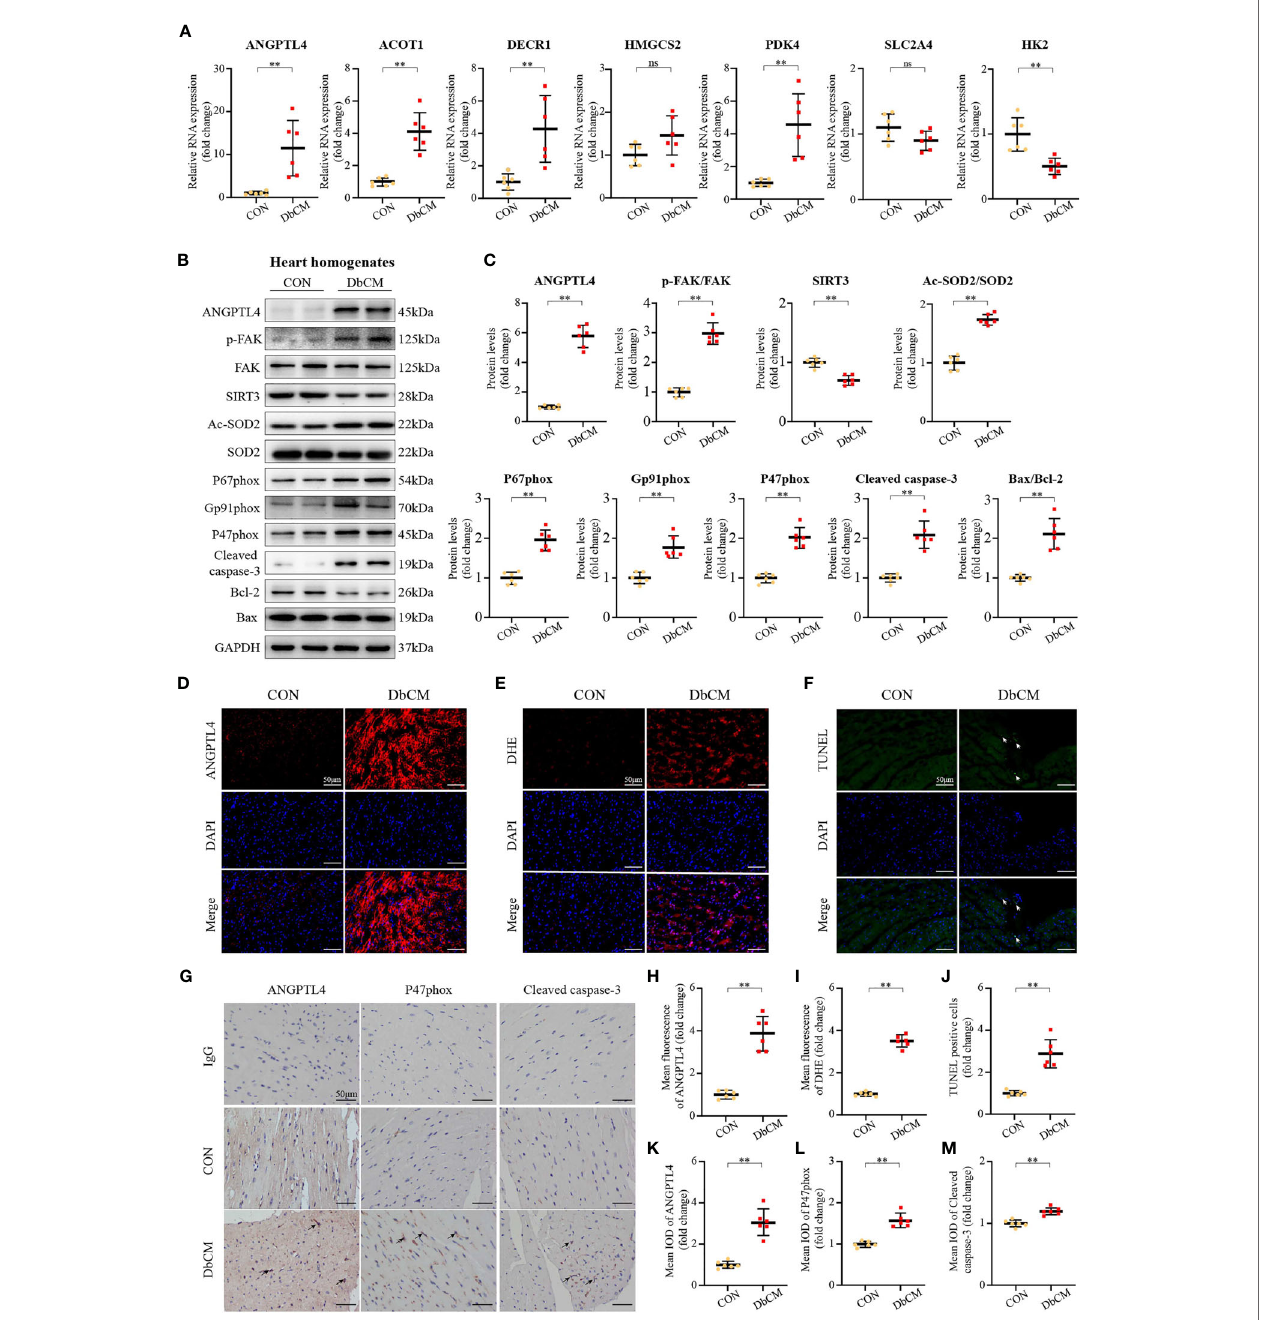
FIGURE 6 | Screening of a novel therapeutic target for DbCM. (A) Relative mRNA expression of hub genes normalized to a GAPDH internal control (n=6 each). Values are expressed relative to control groups. (B, C) Representative Western blots and analysis of ANGPTL4 expression; p-FAK(Y397)/FAK ratio; SIRT3 expression; Ac-SOD2/SOD2 ratio; P67phox expression; Gp91phox expression; P47phox expression; Cleaved caspase-3 expression; Bcl-2 expression; Bax expression. Equal protein loading was con fi rmed using an anti-GAPDH antibody (n=6 each). (D) Representative images of ANGPTL4 fl uorescence in heart sections. Scale bar, 50 m m. (E) Representative images of DHE fl uorescence in heart sections. Scale bar, 50 m m. (F) Representative images of apoptotic cardiomyocytes (200×). The apoptotic cells were detected by TUNEL (green), and the nuclei were detected by DAPI (blue). Scale bar, 50 m m. (G)